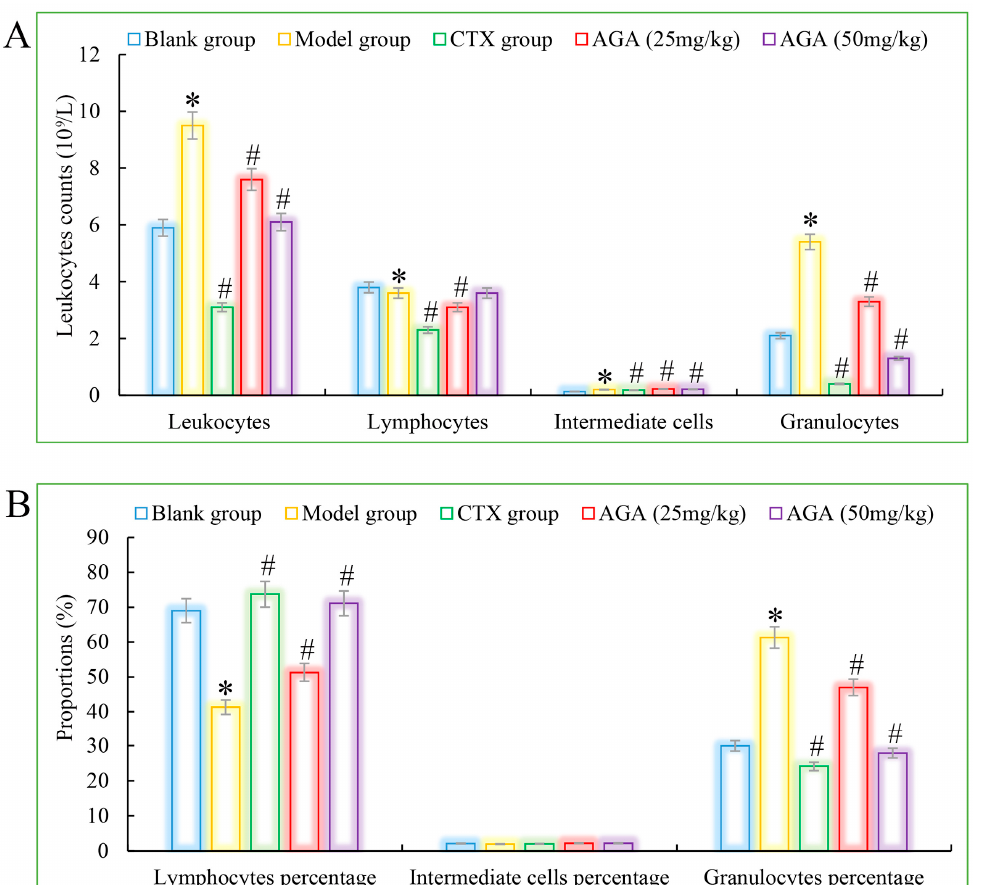
Figure 4. The leucocyte system counts ( A ) and its proportions ( B ) detections of AGA on H22 tumor bearing mice. * p < 0.05, compared with Blank group; # p < 0.05, compared with Model group.